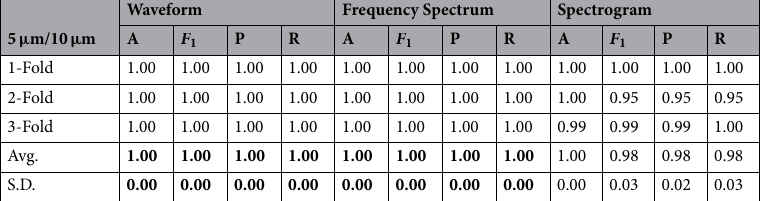
Table 2. Performance of the proposed model in waveform, frequency spectrum, and spectrogram to classify polystyrene microspheres (i.e., cell-mimicking beads) according to their sizes. Significant values are in [bold].